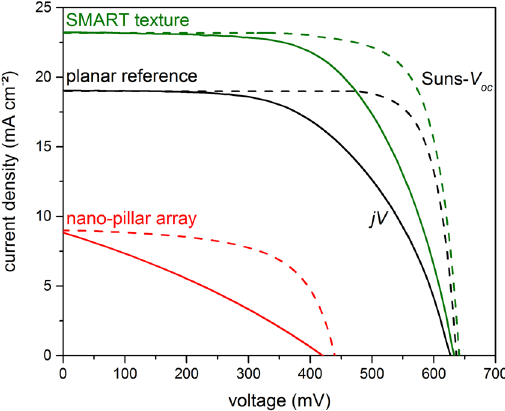
Figure 6. Current-voltage curves of the nano-pillar array from ref. 11 (red), the SMART texture (green) and planar reference (black), as measured with a solar simulator (solid, jV ) and by Suns- V oc (dashed).